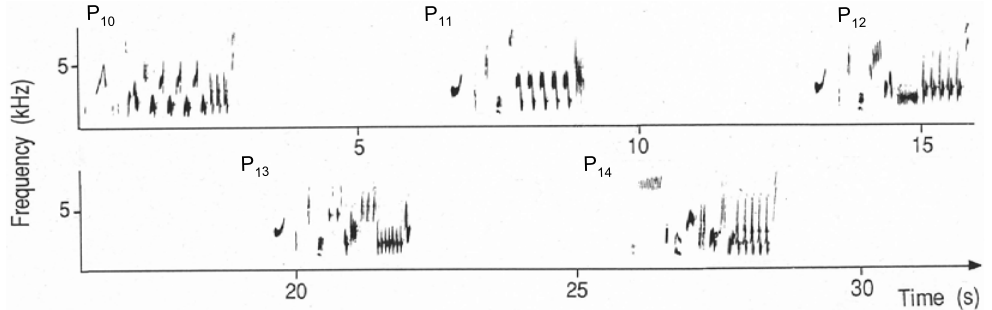
Fig. 6 – Spectographic display of a section of the song string P (pattern cueing), showing the master song-types P10 through P14. Songs 11, 12 and 13 have the same initial song section (here a succession of four identical element-types), whereas the initials of song 10 or 14 are